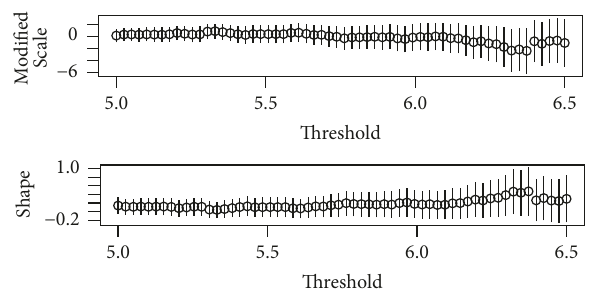
Figure 5: Figure of calibration scale parameters and scale parame- ters of deaths. Table 3: Basic parameter